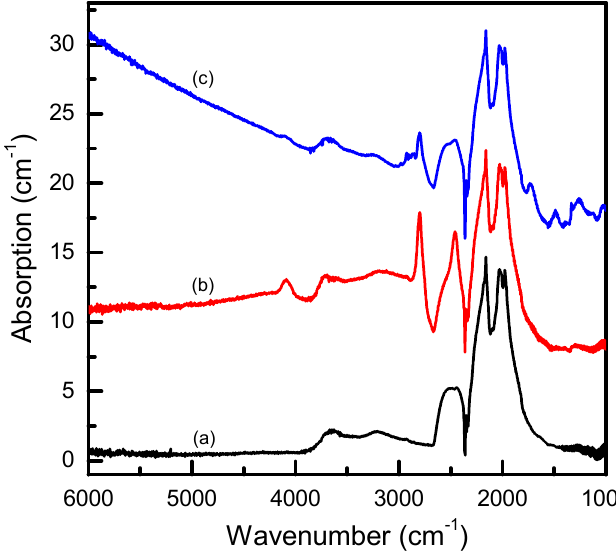
Figure 4. Typical infrared absorption spectra of diamond crystals synthesized in the Mg-10wt%R 2 O 3 -C system. The spectra were measured for ( a, b ) nearly colorless and ( c ) brown crystals from run R-2. The spectra are displaced vertically for clarity.